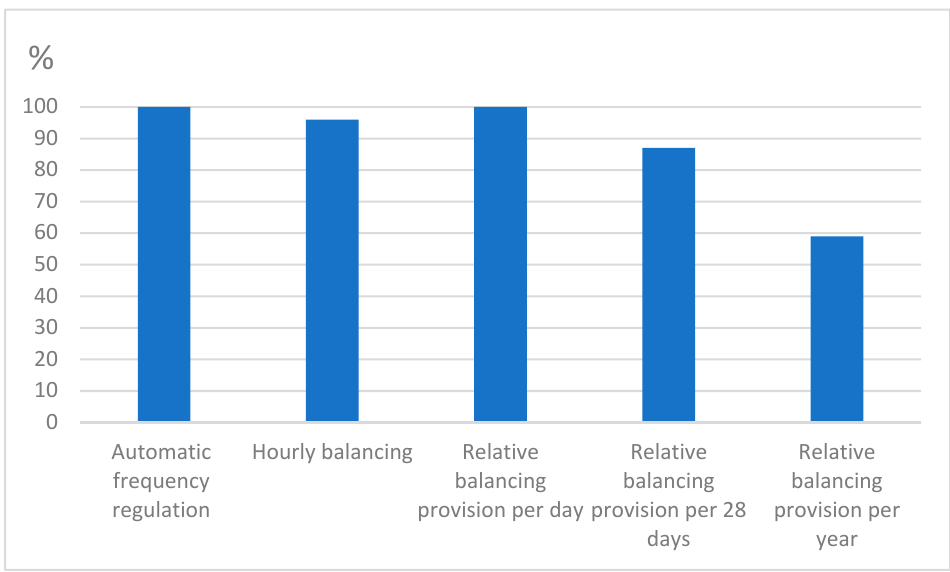
Figure 2. Hydropower’s share of balancing services to the Swedish electric grid during the years 2008–2016, data source [76].